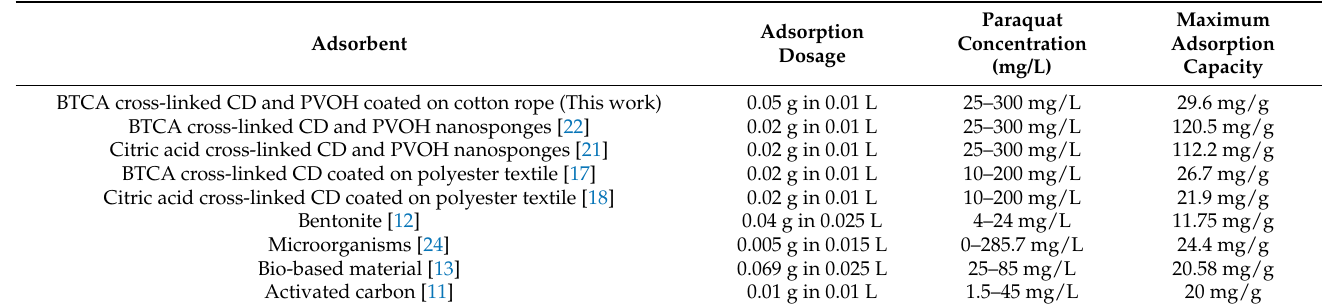
Table 5. Langmuir isotherm for paraquat removal by various adsorbents.